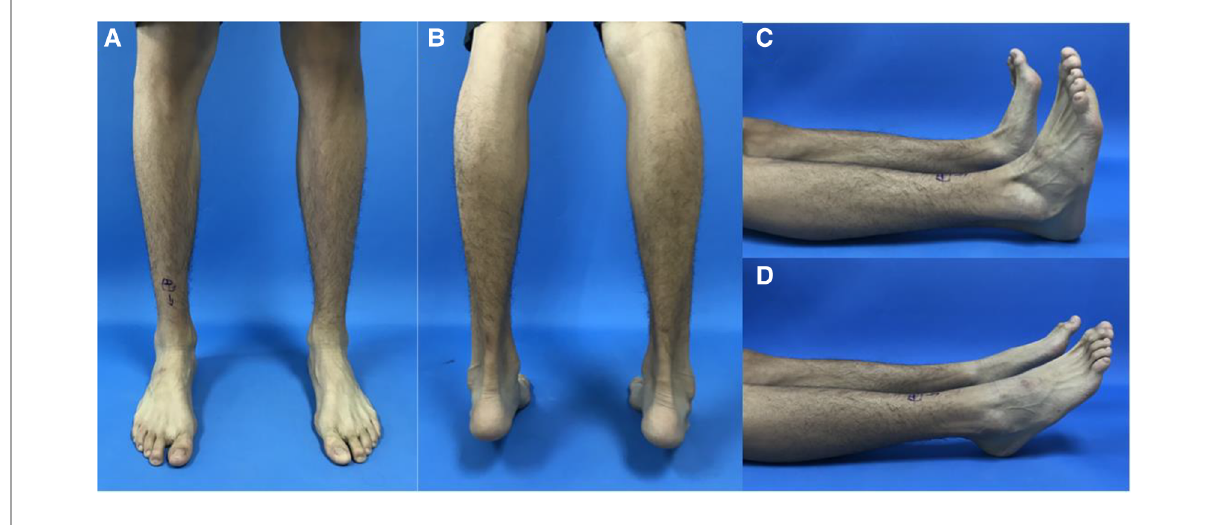
FIGURE 1 Preoperative imaging showed that the bearing capacity of the medial column of the affected foot was weakened, the posterior foot was slightly varus, the posterior foot force line was slightly varus biased, the dorsi fl exion activity was slightly limited, and the plantar fl exion activity was not limited. ( A ) Front view standing on two feet; ( B ) rear view with tiptoe feet; ( C ) lateral view of dorsal extension of both feet; ( D ) lateral view of plantar fl exion of both